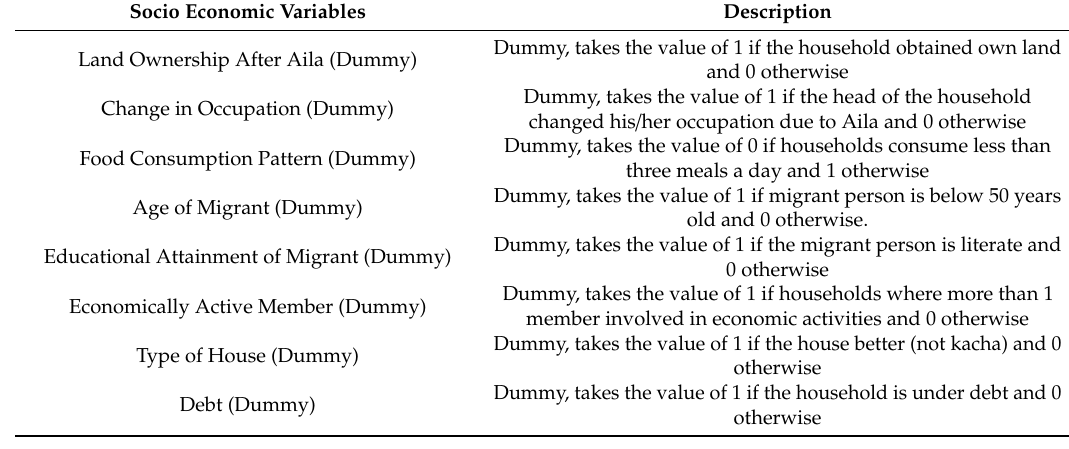
Table A1. Variables with their units of measurement and coding.